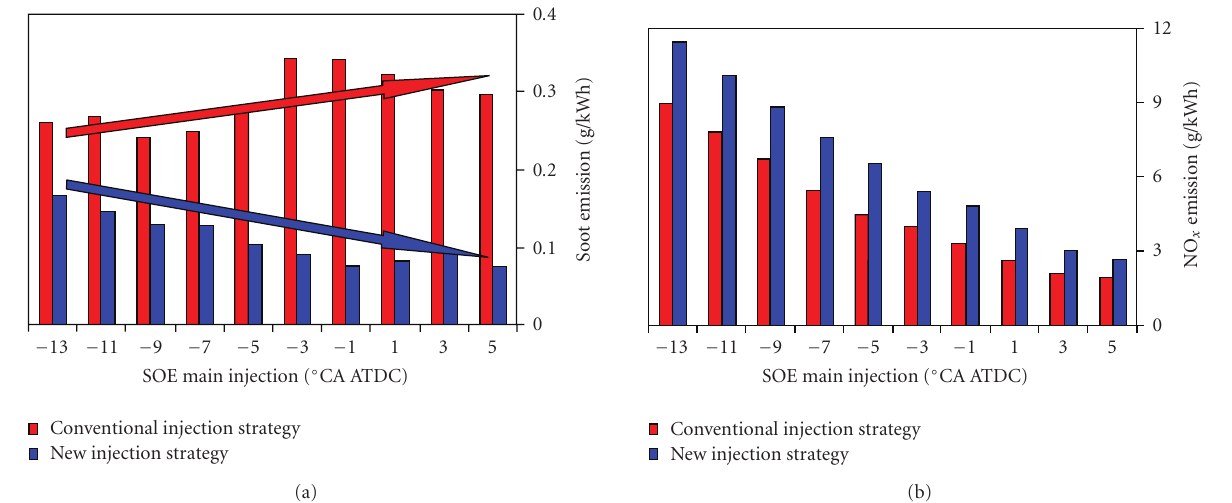
Figure 6: Soot and NO x emissions with injection timing variation and 0% EGR.